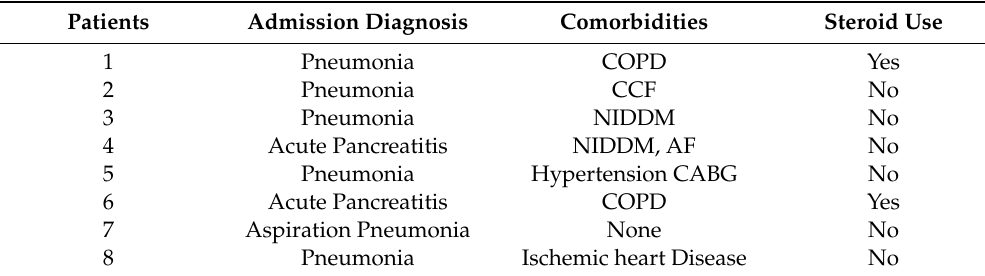
Table 2. Clinical characteristics of the ICU patient’s